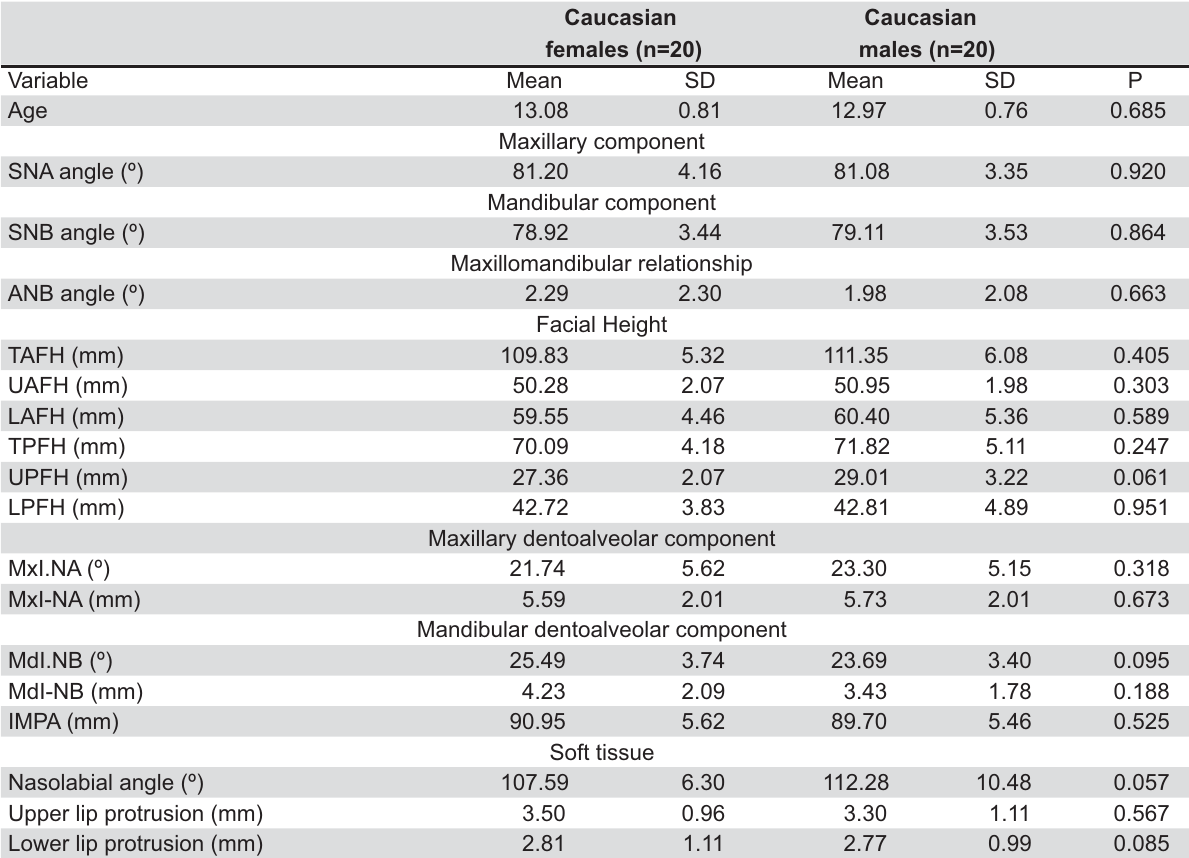
Table 2- Means and standard deviations (SD) of age and skeletal, dentoalveolar, and soft-tissue variables for Caucasian subjects and results of t